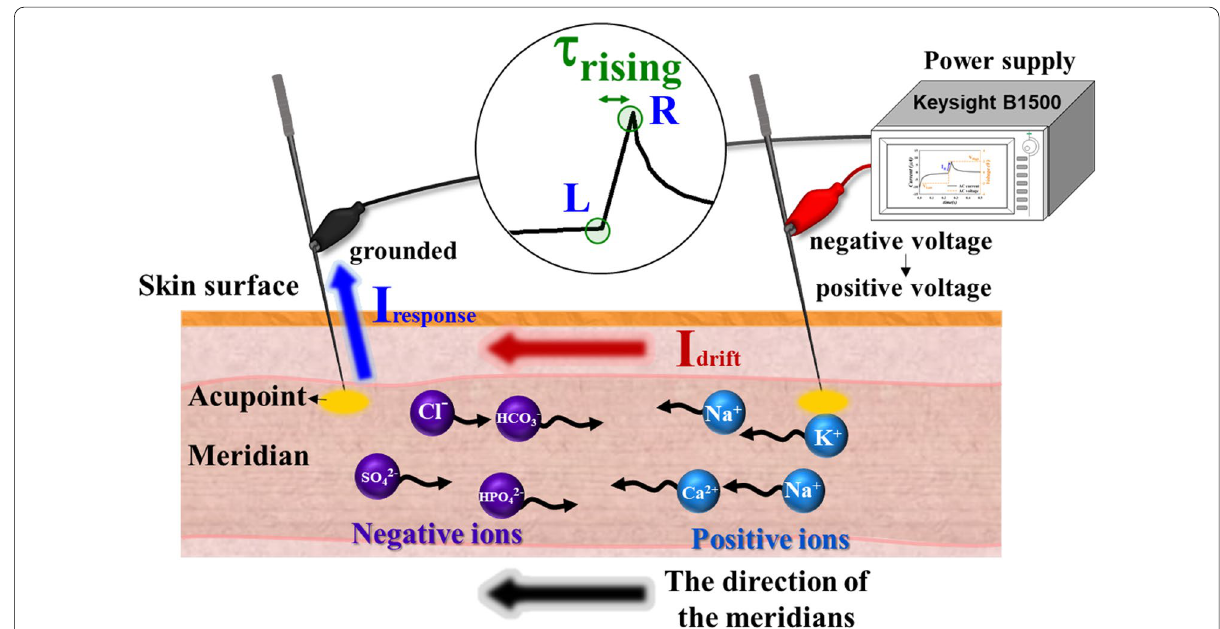
Fig. 6 The direction of the positive and negative ions when the inputted negative voltage changes to a positive voltage of AC wave. Many positive and negative ions exchange instantaneously